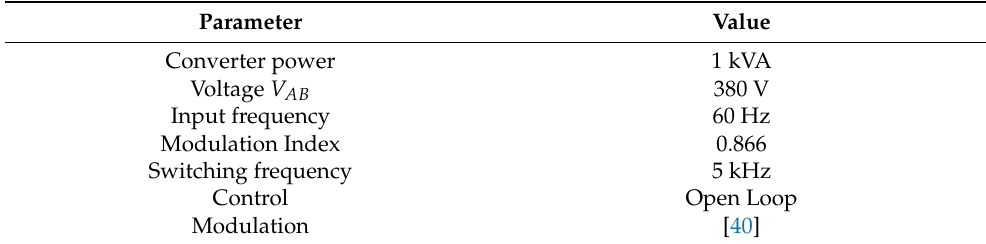
Table 2. Parameters used in CMC